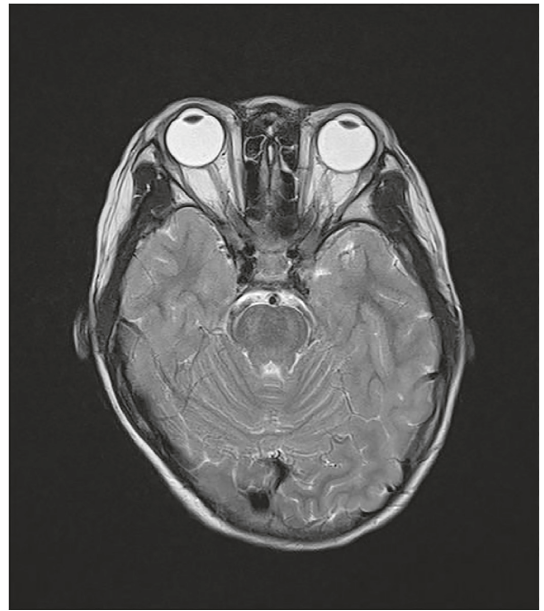
Figure 5: MRI brain showing T2 hyperintensities at posterior and bilateral